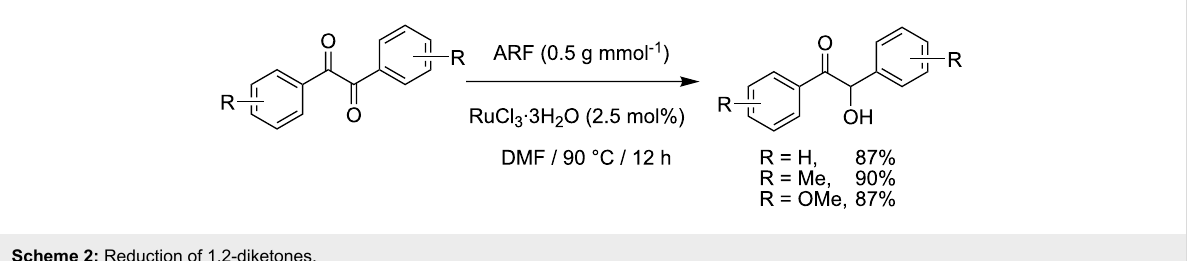
Representative procedure for RuCl 3 · 3H 2 O-catalyzed